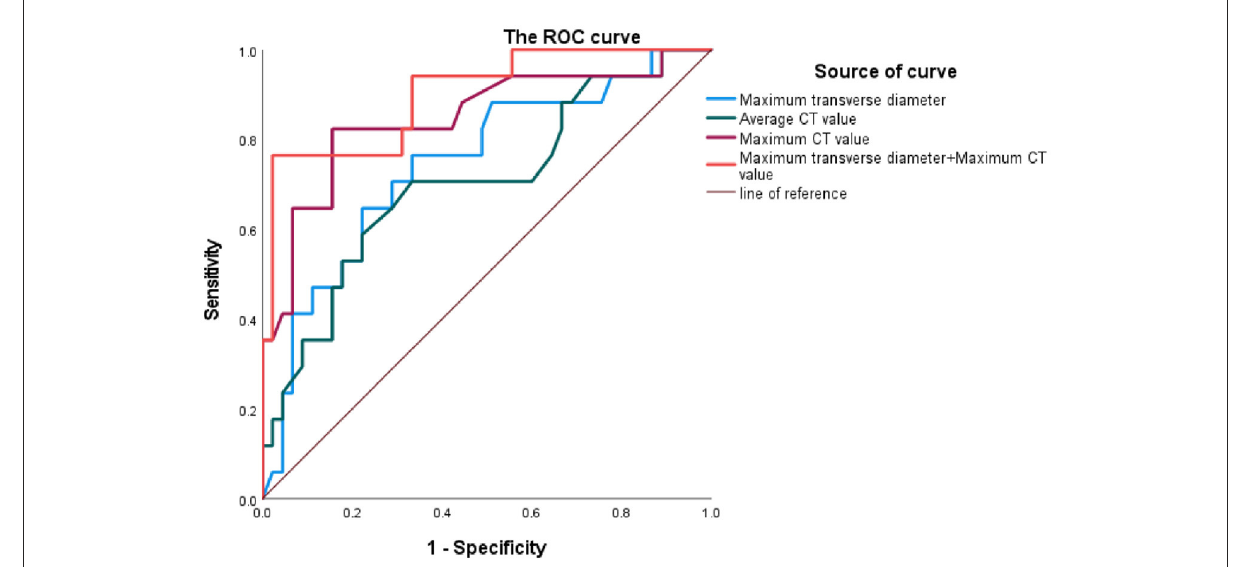
FIGURE4 ROC curves of clinical variables and ruptured abdominal aortic